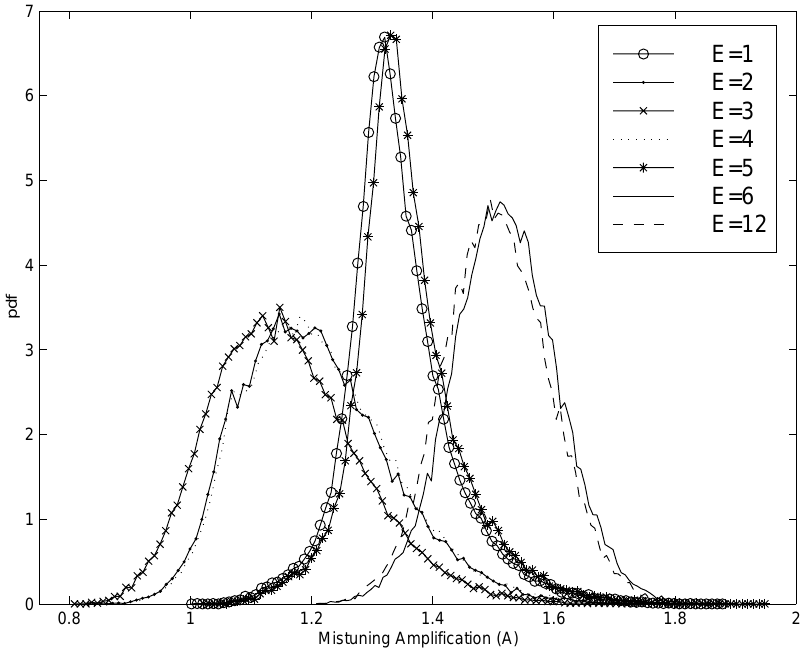
Fig. 4. Probability density functions of mistuning amplification for various engine orders. same frequency. The middle complex conjugate zero pair (near 1.01 on the real axis) causes a sharp